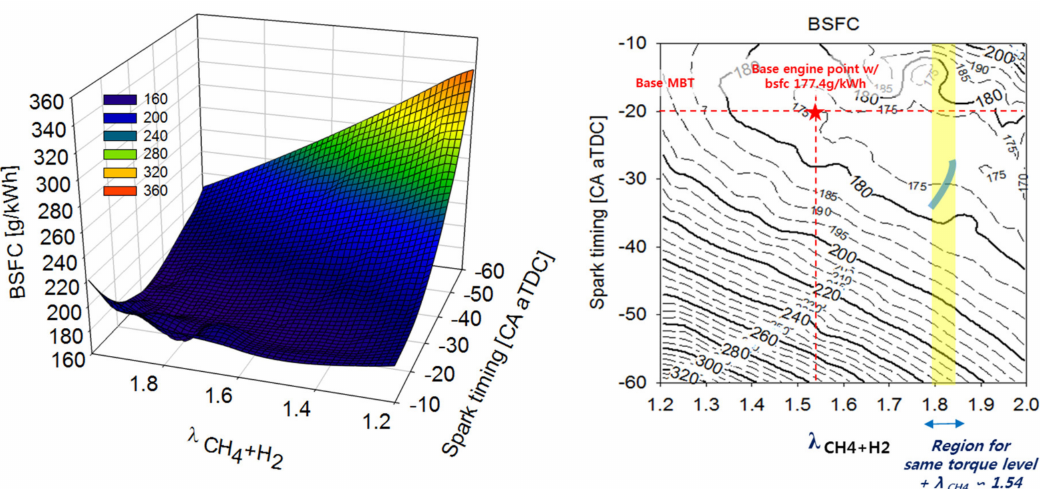
Figure 6. Response surface model: brake specific fuel consumption as functions of spark timing and hydrogen added methane based EAR @1000 rpm.